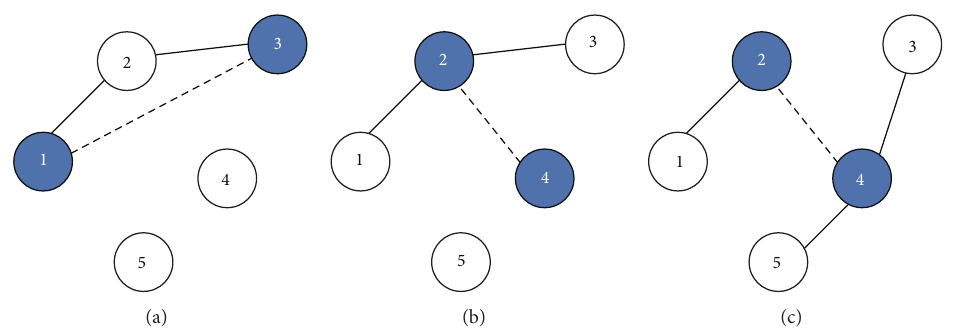
Figure 3: The route constraints of route merging